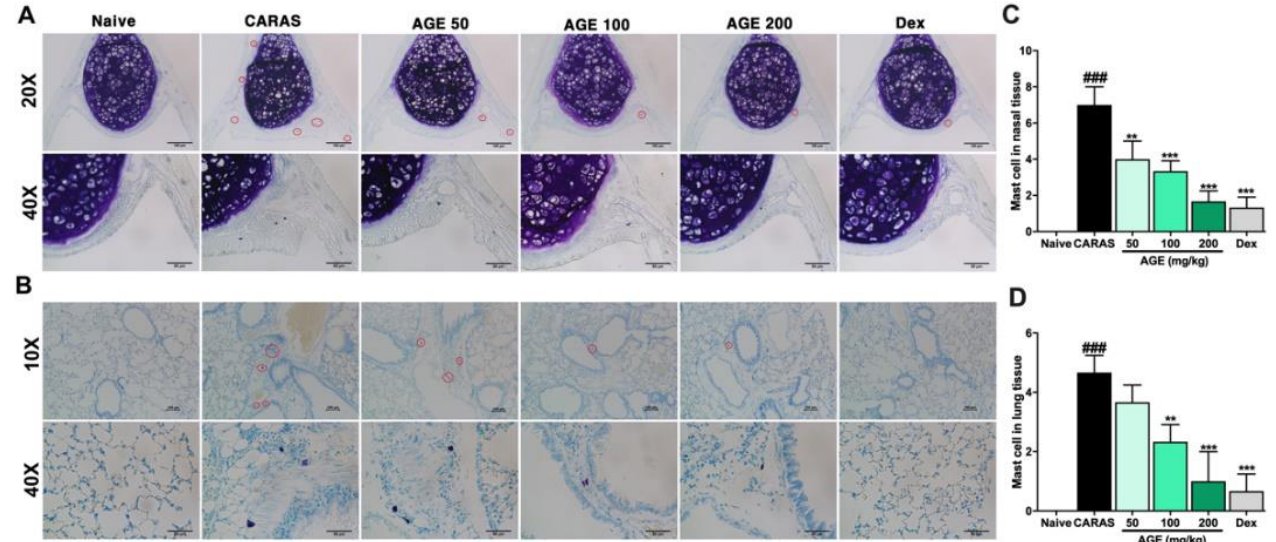
Figure 10. AGE strongly inhibited mast cell infiltration in the ( A ) nasal and ( B ) lung tissues of CARAS mice. The number of mast cells in the ( C ) nasal and ( D ) lung tissues. All pictures were at a magnification of 100 × . By Toluidine blue, mast cells appeared in dark blue dots. The mast cell infiltration of the lung tissues in CARAS mice was notably decreased by the treatment with AGE 100, 200 mg/kg, or Dex 2.5 mg/kg. The red circles indicate mast cells. # Compared to naive, * compared to CARAS. ### , *** p < 0.001; ** p < 0.01. CARAS = combined allergic rhinitis and asthma syndrome; AGE = Artemisia gmelinii extracts; Dex = dexamethasone. Scale bars = 100 µ